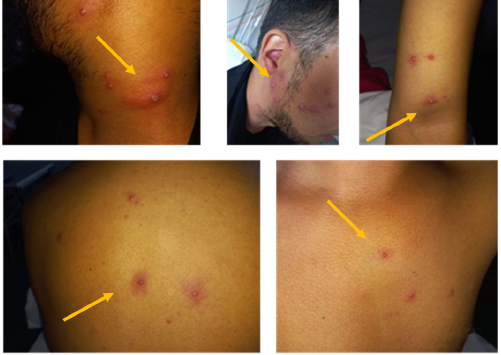
Figure 1. Lesions in different body areas (from left to right: neck, face, arm, back, chest).